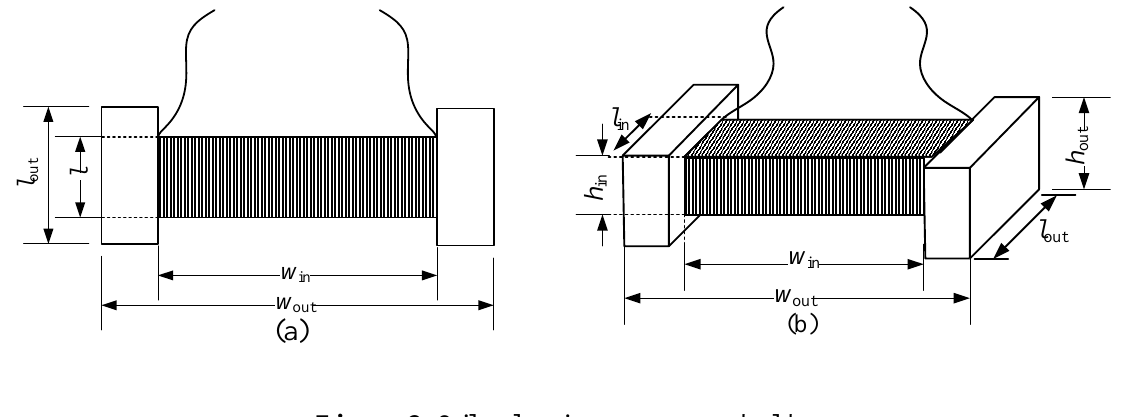
Figure 2. Oil palm ripeness sensor holder.